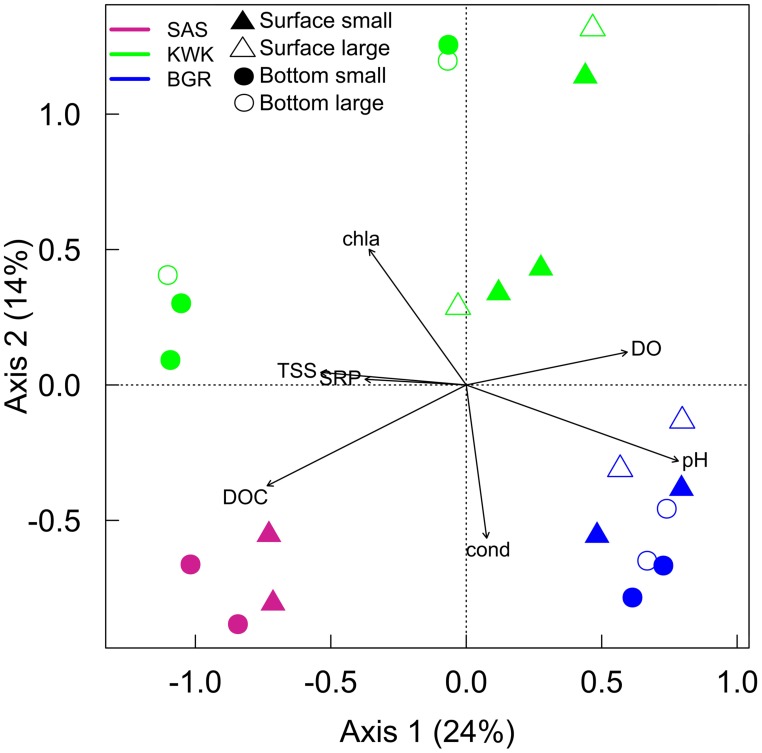
Distance-based redundancy analysis ordination plot showing selected environmental variables that were significantly correlated with sample distribution. Abbreviations for the environmental variables are given in Table 1